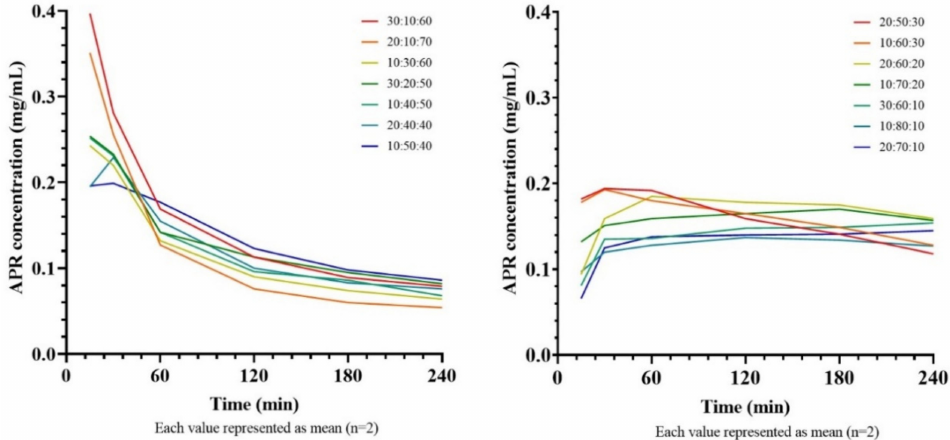
Figure 9. Concentration-time curves of saturated SNEDDS formulations.